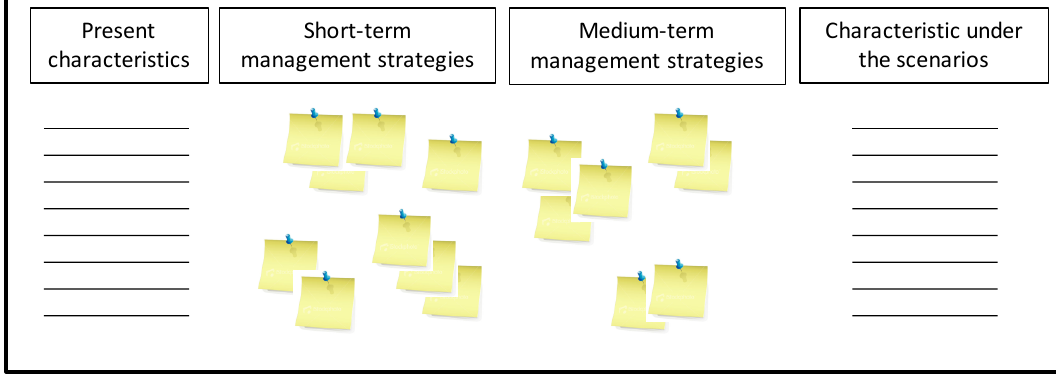
Fig. 2. Flux-diagrams of interactions of the 4 scenarios. Drivers of change are illustrated in shaded square boxes, actors (stakeholder groups) in violet ellipses, aspects (main components of the system) in white ellipses, factors (sub-components of the system) in green ellipses and results or responses in white square boxes. The arrow colors indicate cause, a positive effect, negative effect or indeterminate